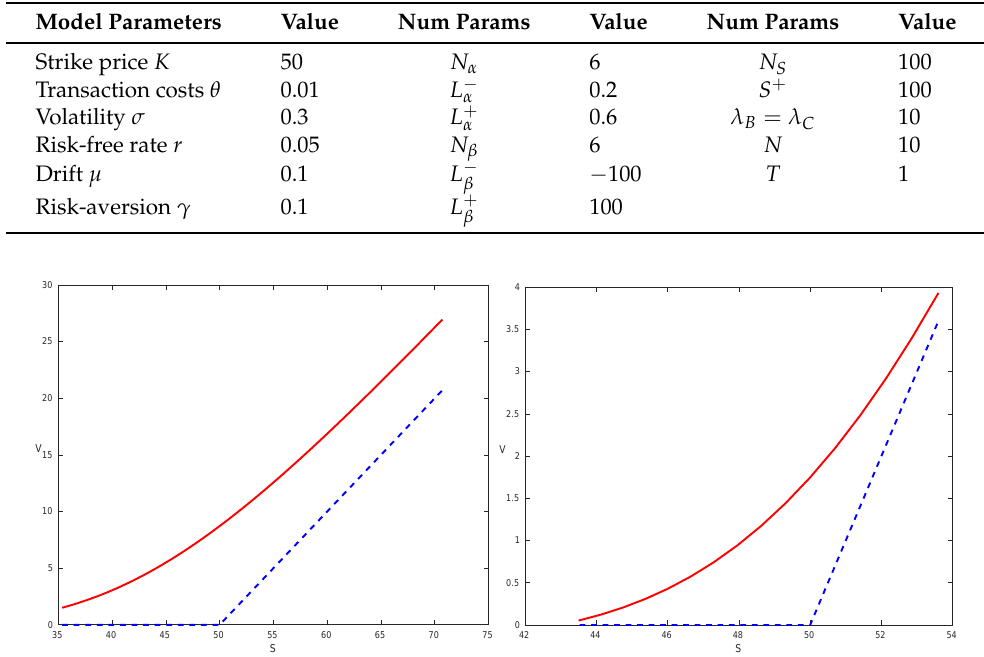
Figure 1. Linear ( left ) and exponential ( right ) utility indifference call option buyer price as a function of the underlying asset price S with the wealth function parameters α = 0.467, β =